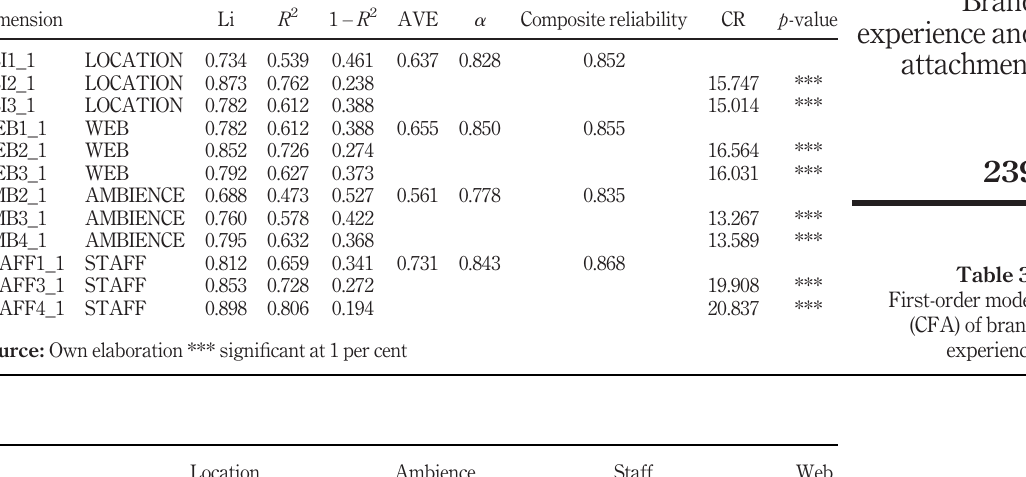
Table 4. Discriminant validity